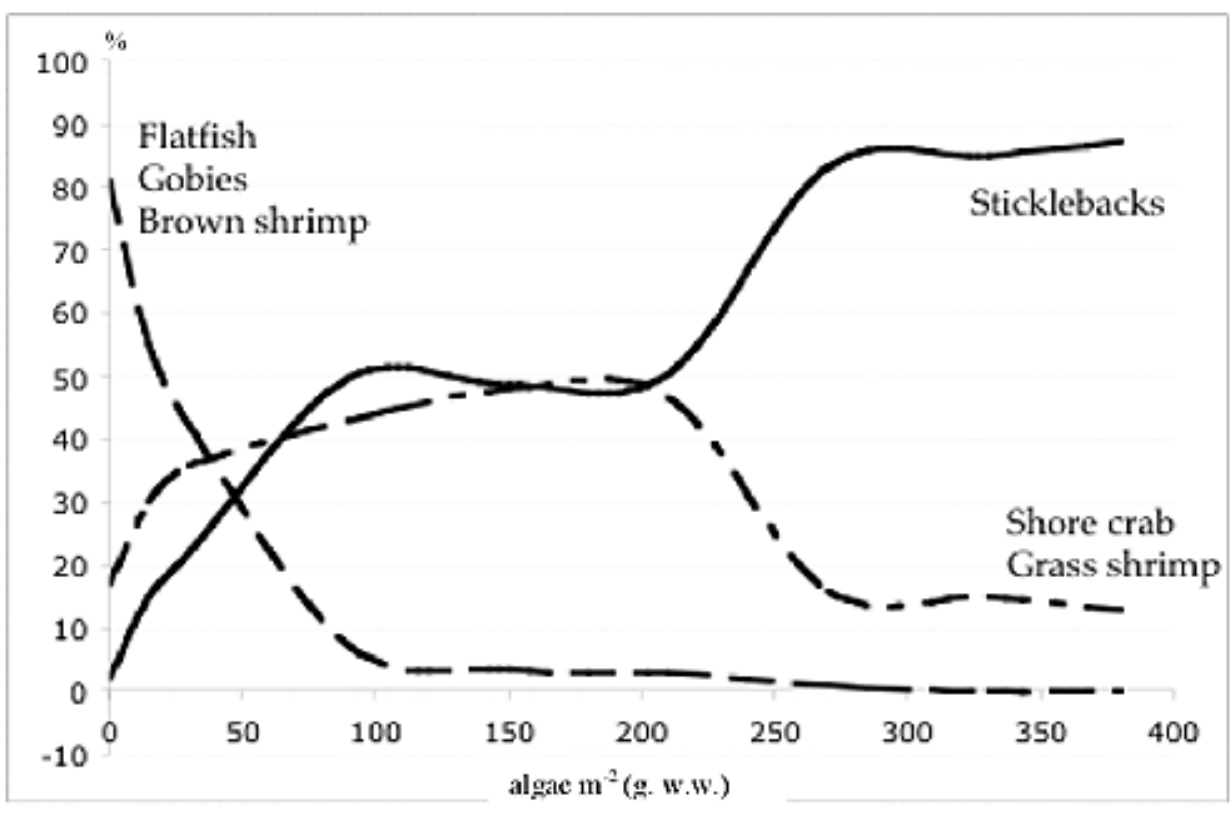
Fig. 2 . A schematic/conceptual illustration of major changes in community structure with increasing density of filamentous algae. The smoothened lines (running average) were based on 400 quantitative samples (1 m 2 ) of epibenthic fauna and filamentous algae to illustrate the significant change in community structure in relation to algae (ANOSIM-test: Global R = 0.751, p<0.001; Wennhage and Pihl in press